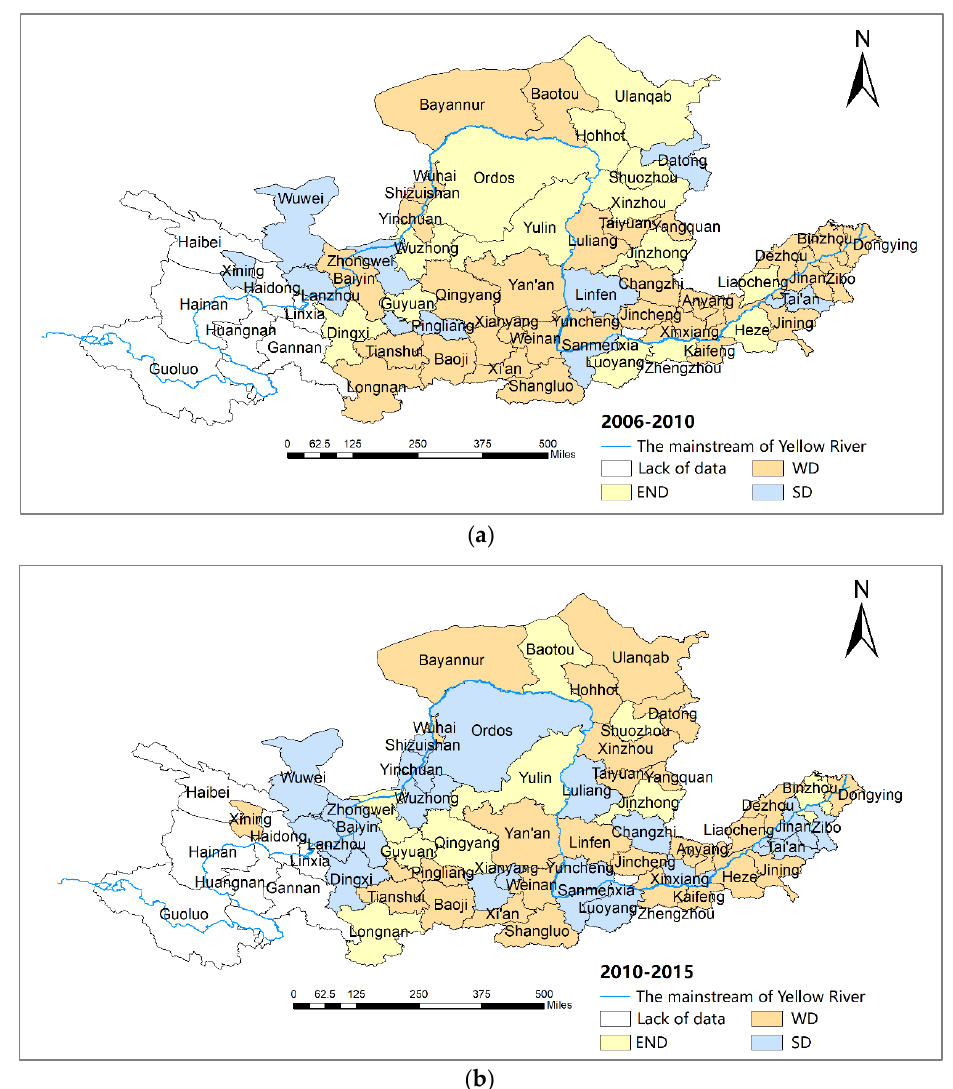
( c ) Figure 3. Decoupling states of cities in the YRB, 2006 – 2019. ( a ) Decoupling states of cities, 2006 – 2010. ( b ) Decoupling states of cities, 2010 – 2015. ( c ) Decoupling states of cities, 2015 – 2019. 4.1.2. Two-Dimensional Decoupling Analysis Based on the EKC curve of Equation (8), Figure 4 and Table 7 identify the regression results. All variables are significant at a 5% significance level. Figure 4 shows an inverted curve of carbon emissions and real GDP per capita of cities along the YRB. According to